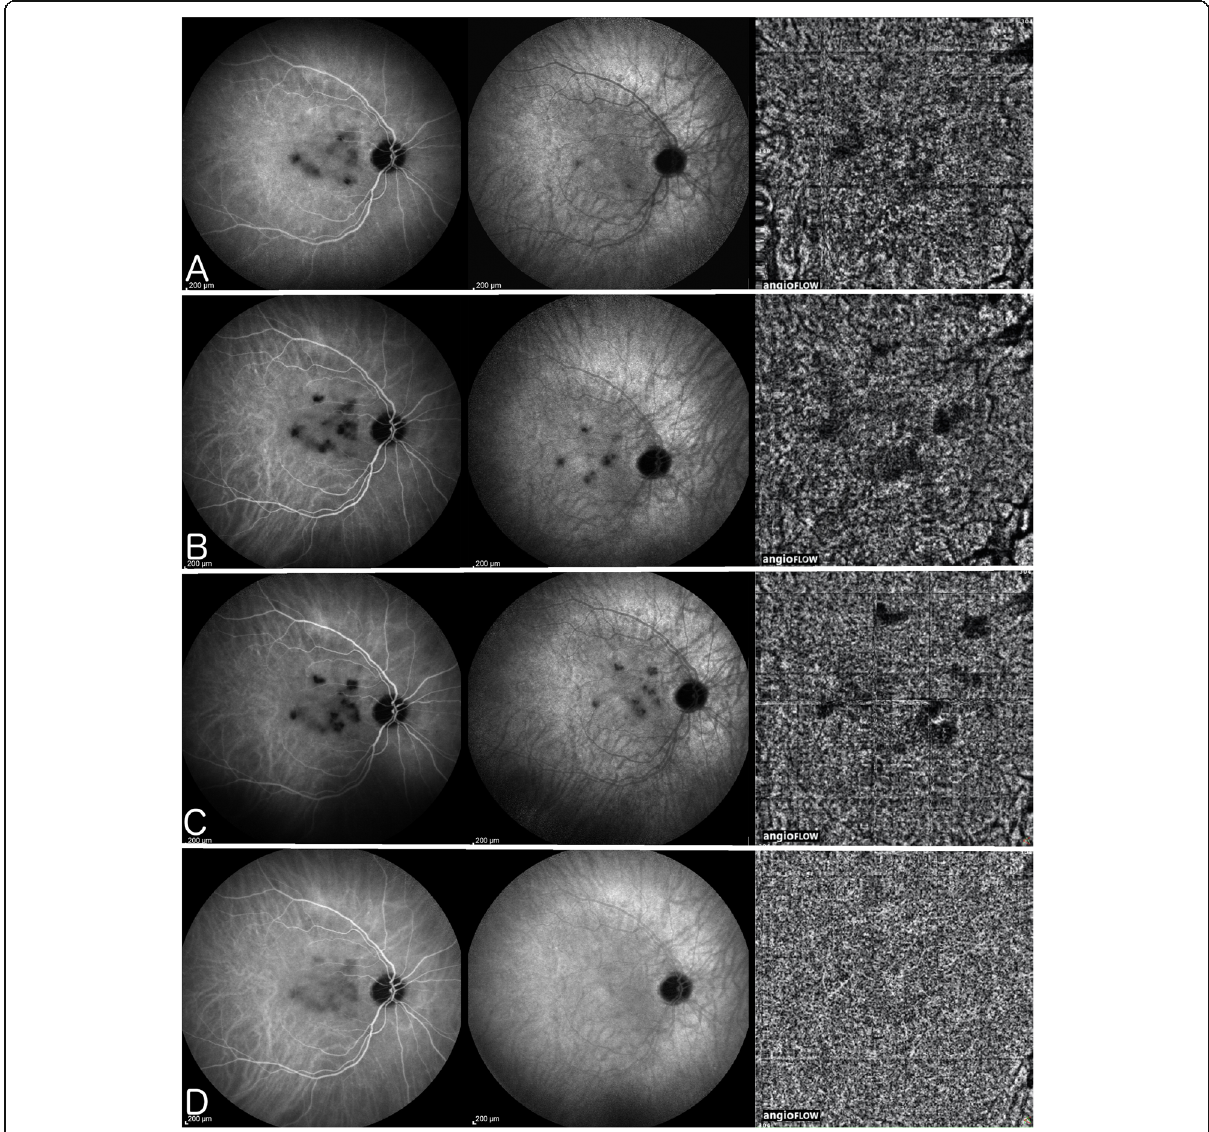
Fig. 13 Serpiginous choroiditis - Parallel images of intermediate phase ICGA (left column), late phase ICGA (middle column) and 6x6mm OCT- Angiography (right column) of the right eye during follow-up ICGA of the right eye reveals macular hypofluorescent lesions better seen in the intermediate phase ICGA (left column) corresponding to choroidal hypo or non-perfused areas. These lesions increase in size and number (A) (B) (C) until aggressive immunosuppression is introduced (D); OCT-A pictures evolve in parallel with ICGA frames with faint dark areas visible (A, B, and C – right column), and disappearing after aggressive immunosuppression is introduced (D, right); involvement of extended areas depending on larger vessels, probably precapillary arterioles, are needed to produce a drop-out on